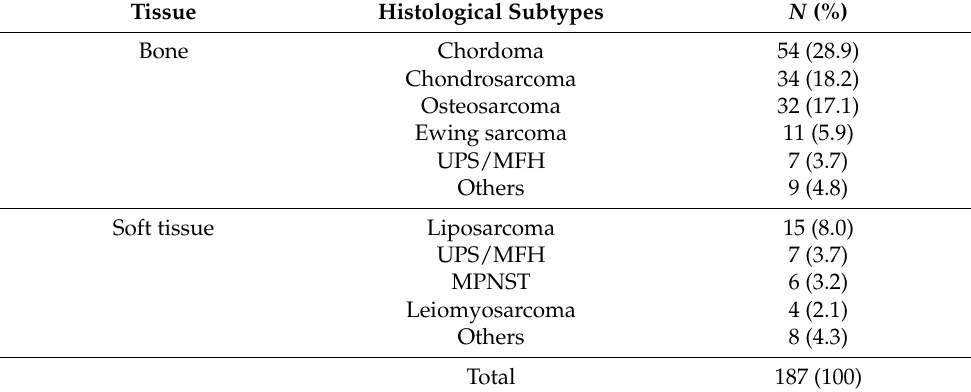
Table 2. Histological subtypes of primary